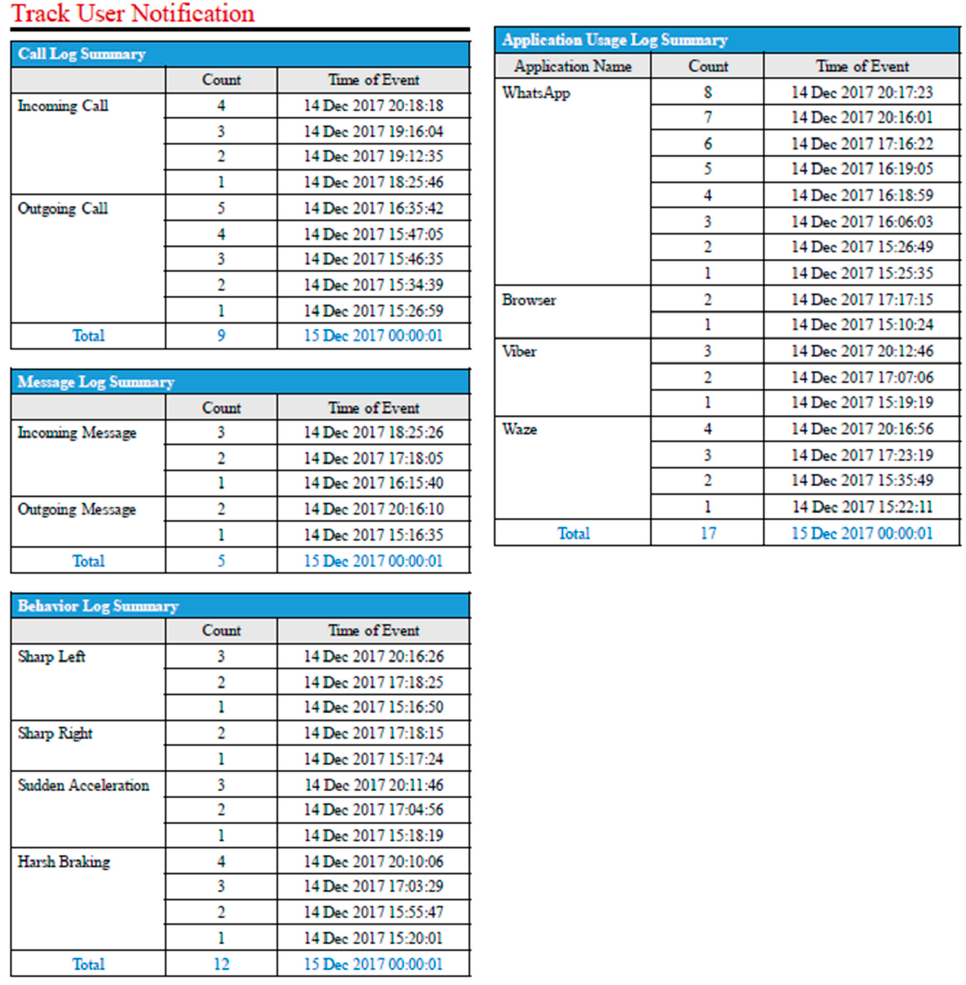
Figure 17. Screenshot of report generated at the end of the day.